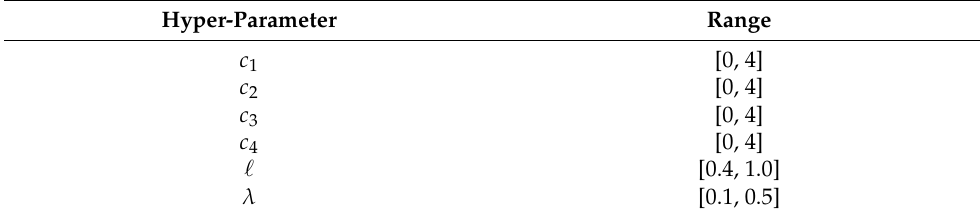
Table 2. Range for hyper-parameter optimization.